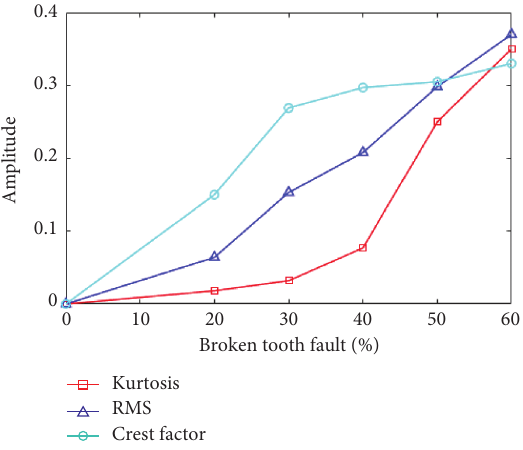
Figure 9: Time-domain statistical